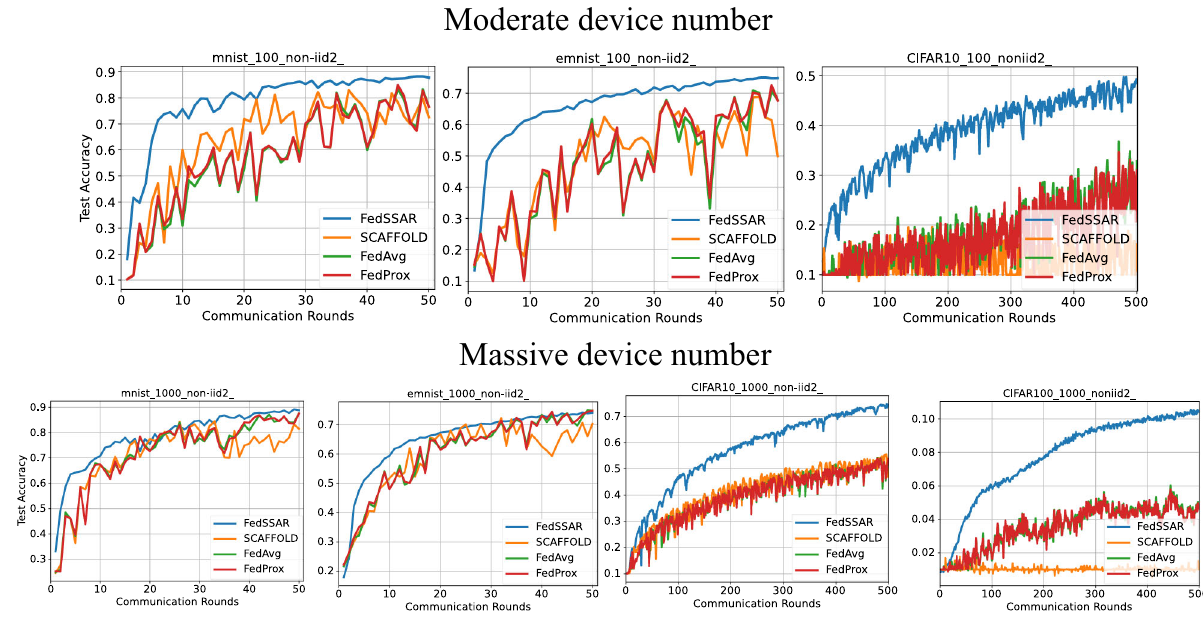
Fig. 5 Validation accuracy of FedSSAR and other methods, using decreasing learning rate η t and weight decay: 10 − 3 to achieve the best training performance during the last 50 training rounds for MNIST and EMNIST-L, 500 training rounds for Cifar-10 and Cifar-100